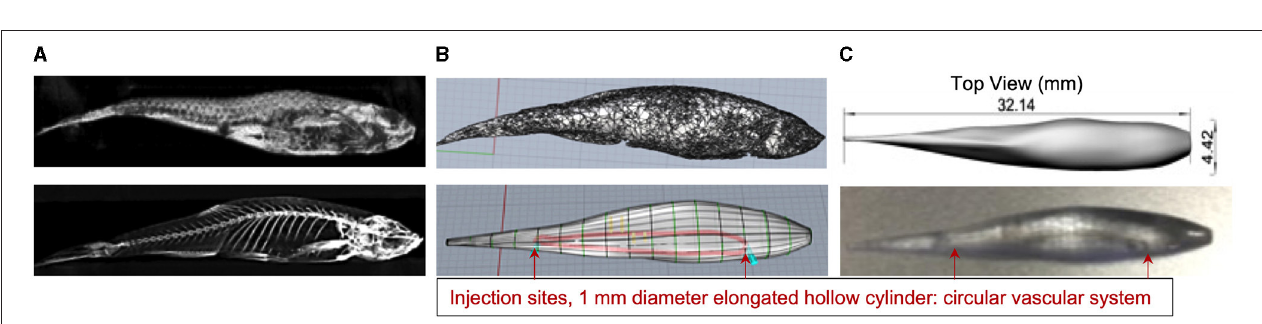
FIGURE 1 | (A) Rhinoceros CAD schematic of zebrafish imaging chamber platform prototype set to print for feasibility testing. Bed holder/slip was printed for use on the Mediso nanoPET/CT. (B) Top view showing dimensions. (C) Displays the design for the environmental monitoring sensor cables and the water in/out flow channel, which run below imaging platform. A reconstructed PET/CT acquisition is shown in (D) in which an adult zebrafish can be seen in the imaging platform.